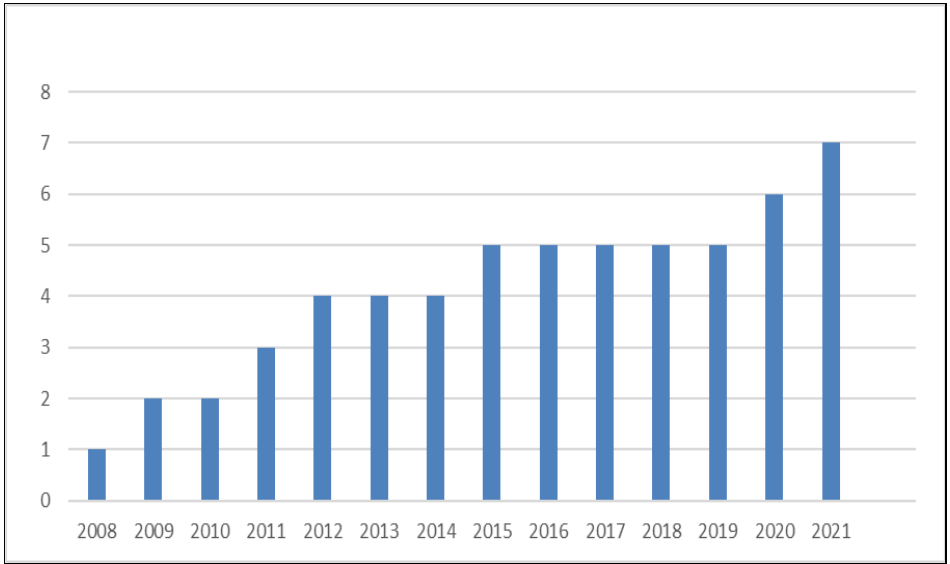
Figure.2.Research Publication Trend Regarding Investors’ Biases & Stock Return Volatility During